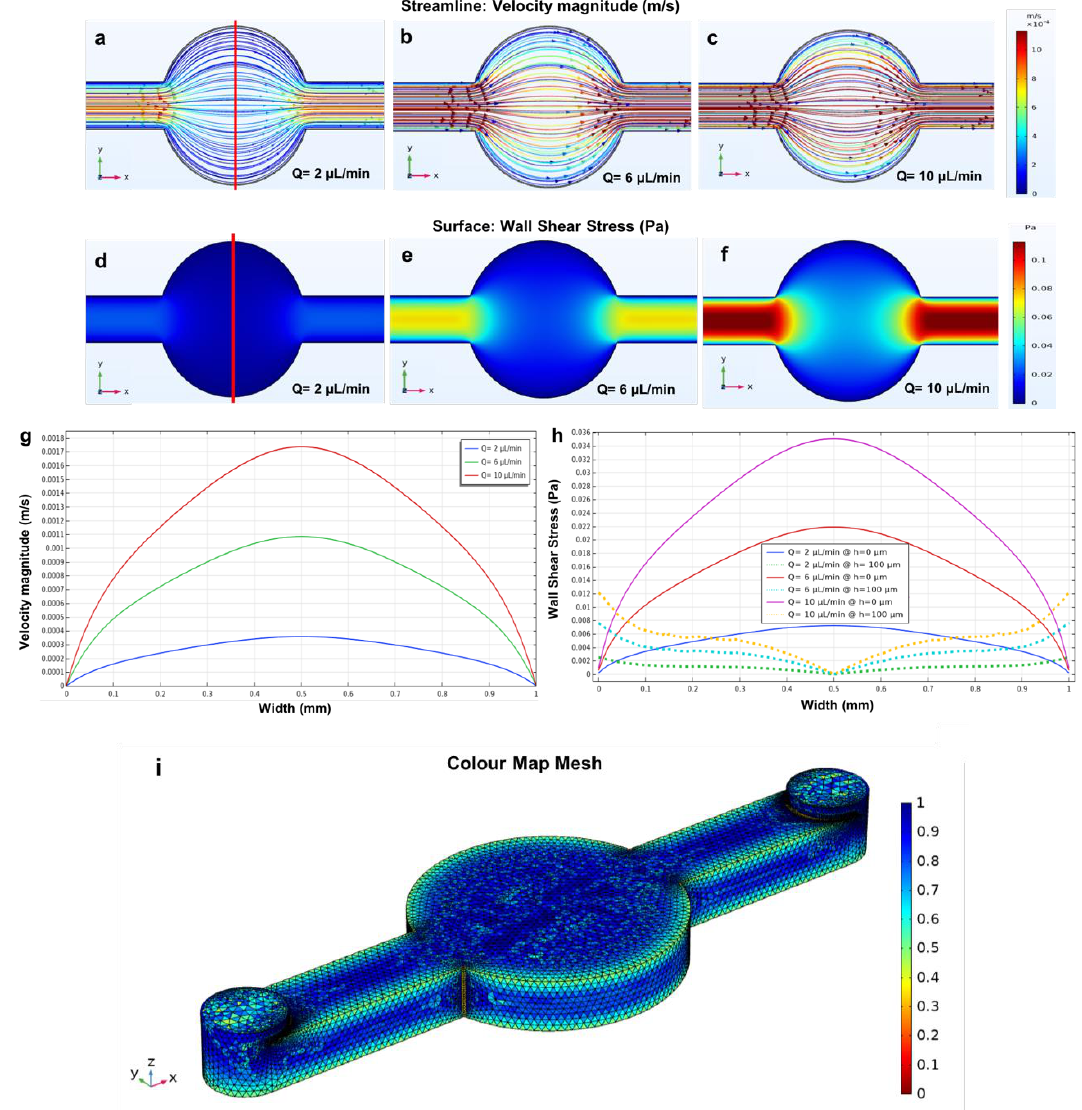
Figure 5. Simulated shear stress and velocity magnitude along the red line are plotted versus the width of the circular microchamber using three different flow rates of 2, 6 and 10 µL/min. ( a – c ) The fluid flow; ( d – f ) wall shear stress simulations within the circular microchamber with a microchannel height of 200 µm and flow rates of 2, 6 and 10 µL/min; ( g ) the velocity profiles; ( h ) wall shear stress profiles at h = 0 µ m (solid lines), which is at the bottom of the microchamber, and h = 100 µ m (dotted lines), which is the shear stress at the middle of the microchamber; ( i ) generated mesh density study of the circular microchamber. The small dots in Figure 5a–c are the velocity direction